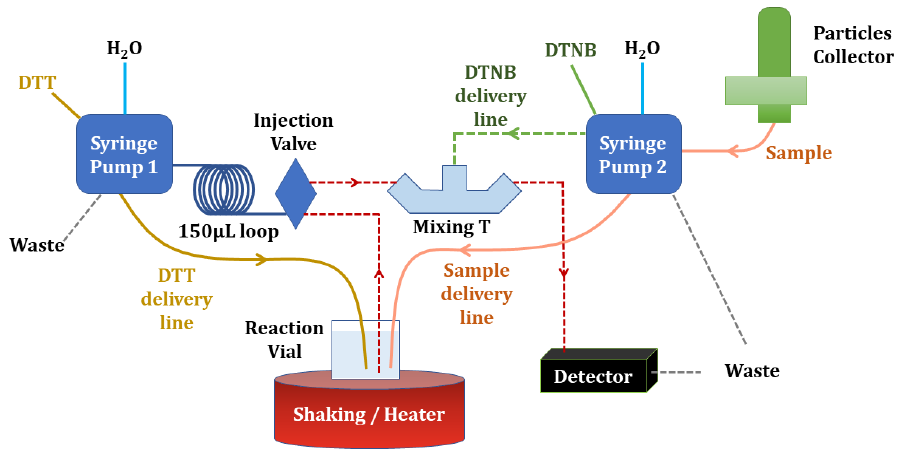
Figure 4. o-MOCA online system flow diagram, adapted from Eiguren-Fernandez et al. [37] . However, in the previously mentioned works including DTT analysis, the maximum number of continuous online measurement days on the field of 3 days (with 3 h time res- olution) was reached only by Eiguren-Fernandez et al. [37]. This was a huge limitation for